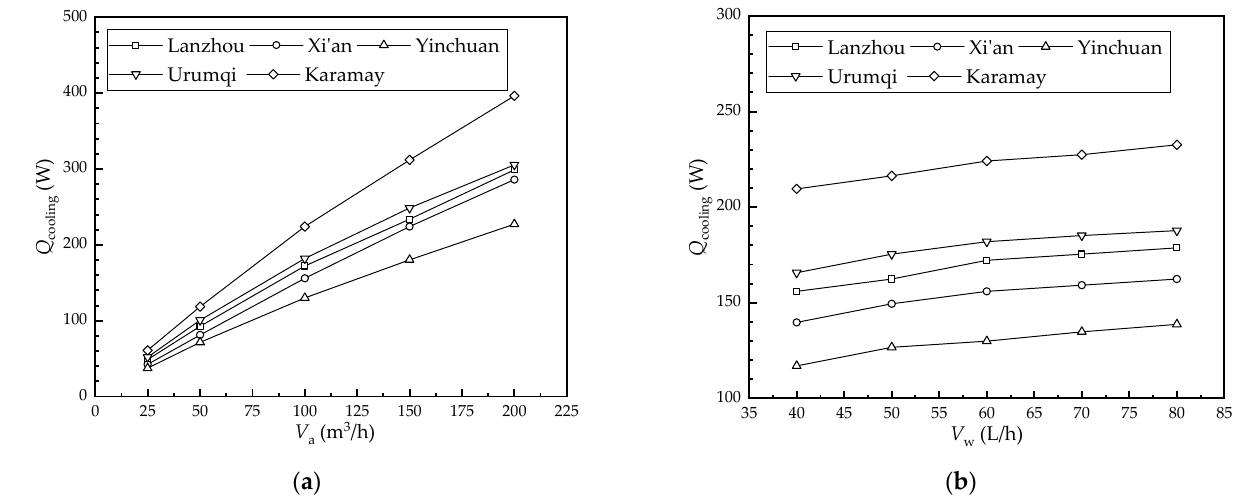
Figure 9. Effect of the flow rate on the cooling capacity in each city: ( a ) air flow rate; ( b ) water flow rate.